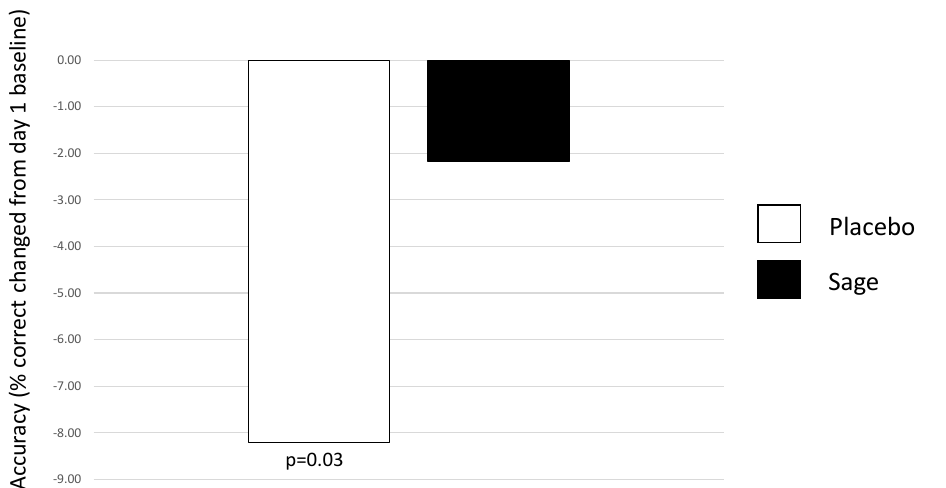
Figure 9. Pure chronic main effect of treatment on day 29 for name-to-face recall accuracy: a significant acute main effect of treatment ( p = 0.03) was observed on day 29 where accuracy was significantly lower (as compared to pre-dose performance on day 1) in the placebo condition as compared to the sage condition.